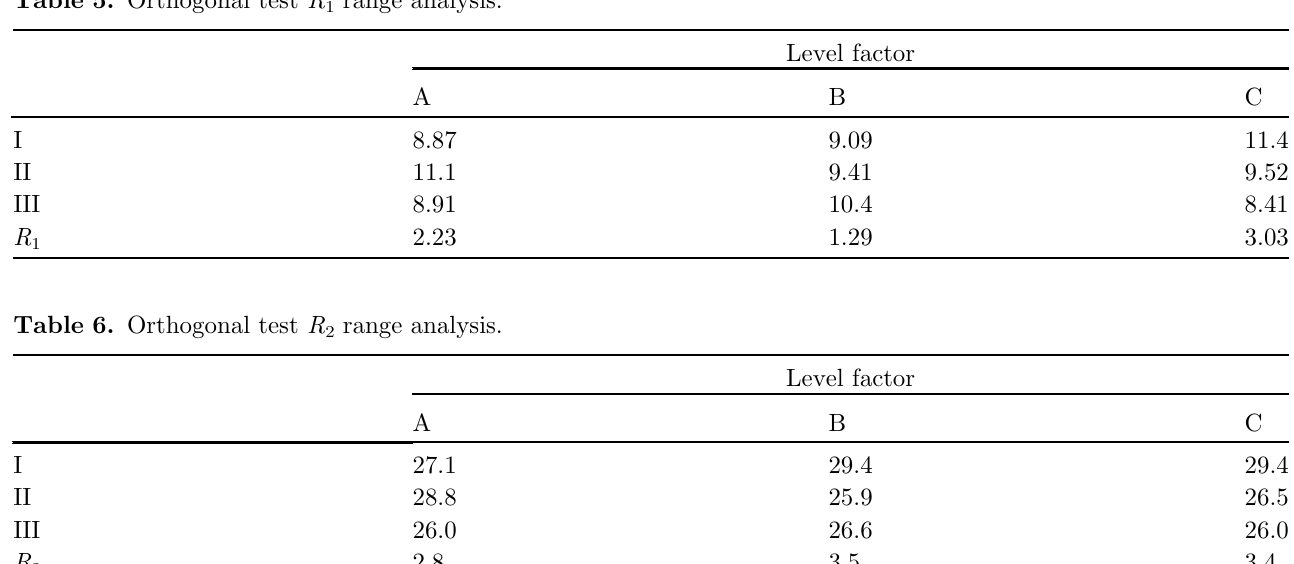
Table 5. Orthogonal test R